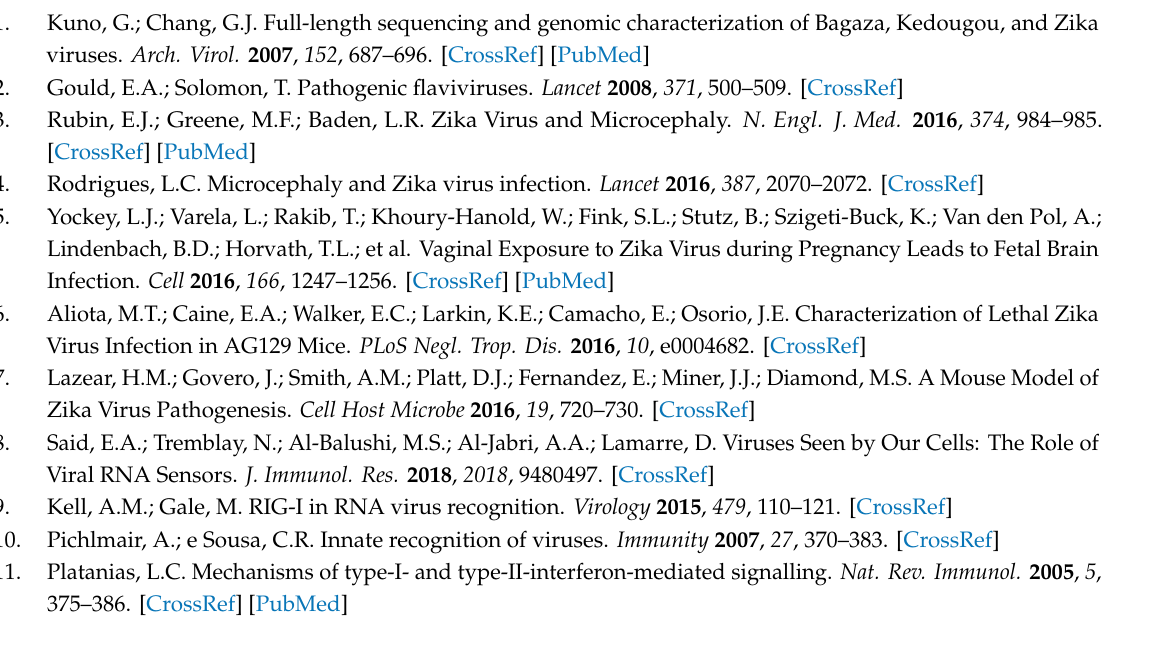
Table S1: Primer sets for PCR used in this study. Table S2: Primer sets for qRT-PCR used in this